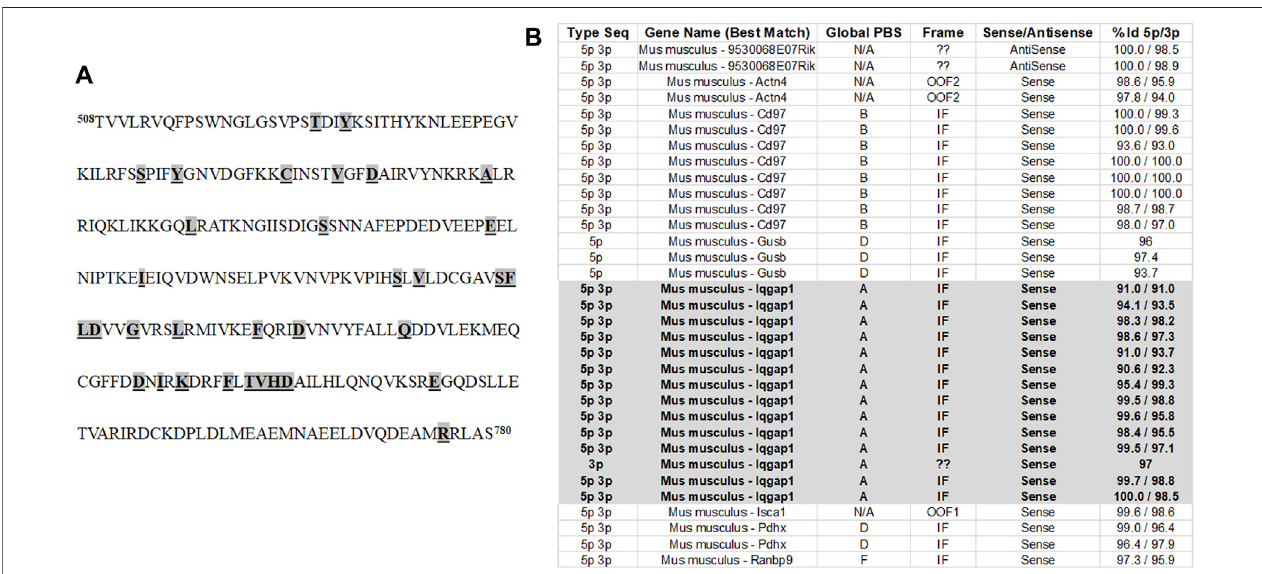
FIGURE 1 | Identi fi cation of IQGAP1 as a pendrin binding partner. (A) The C-terminus of pendrin was used as bait in Y2H in order to identify the protein(s) that interactwithpendrin.TheC-terminusofmousependrinproteinspanningaminoacids508 – 780wasusedinY2Hstudiesinordertoidentifytheproteinsthatinteractwith pendrin.ThisregionwasusedbecauseitcontainstheSTASdomain.Themissensemutations(highlighted,boldedandunderlined)correspondtothoseofthataffectthe functionofthehumanpendrinproteinandareassociatedwithPendredSyndromeandDFNB4. (B) Ourstudiesidenti fi edatotalof33interactionsbetweenpendrin and prey sequences. Of these only 22 interactions were shown to be speci fi c while others we excluded due to out of frame translation, reversed direction of the cloned sequence, or low af fi nity of the bait/prey interaction. The interaction with IQGAP1 represented 14 of the 22 signi fi cant interactions. Based on the Global PBS score, IQGAP/pendrininteractionhadaveryhighdegreeofcon fi dence.TheGlobalPBSscoreisautomaticallycomputedthroughalgorithmswiththefollowingscoringsystem: A) Very high con fi dence in the interaction; B) High con fi dence in the interaction; C) Good con fi dence in the interaction; D) Moderate con fi dence in the interaction; E) Interactionshighlyconnectedpreydomains,warningofnon-speci fi cinteraction;andF)Experimentallyproventechnicalartifacts.InadditiontoIQGAP1, theY2Hsystem alsoidenti fi edCD97asaproteinwitha “ highcon fi denceofinteraction ” givingitaGlobalPBSscoreofB.TherelationshipbetweenpendrinandCD97asabindingpartner needs further examination. The % Id 5p/3p indicates the degree of identity to the putative binding